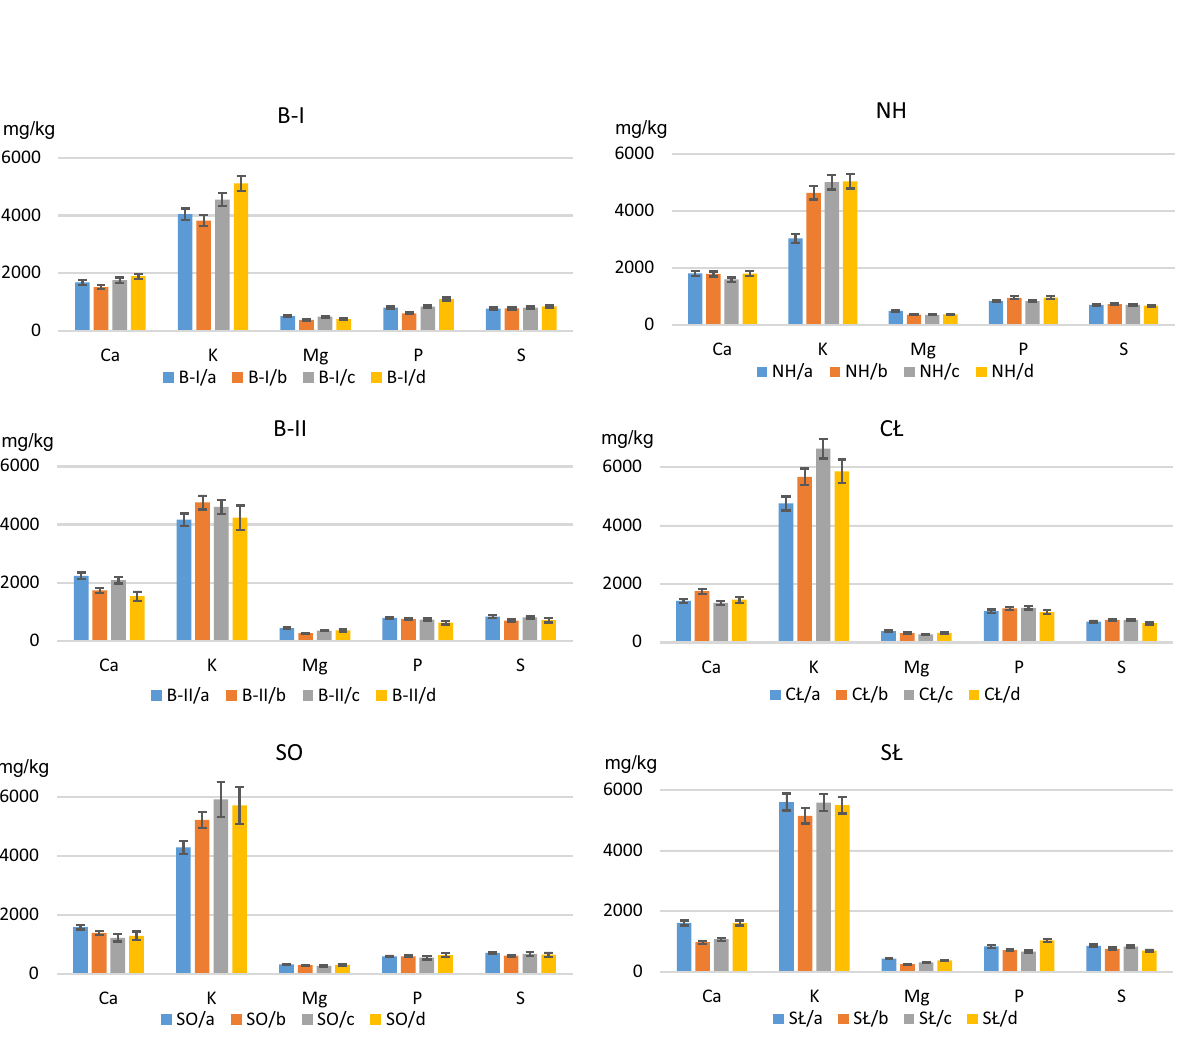
Figure 5. The content of macroelements in lettuce, growing on: a —unfertilized soil, b —mix of straight fertilizers, c —multinutrient fertilizer and d —organic fertilizer. B-I, B-II—Bukowno region, SO—Sosnowiec, NH, CŁ—Nowa Huta region, SŁ—control